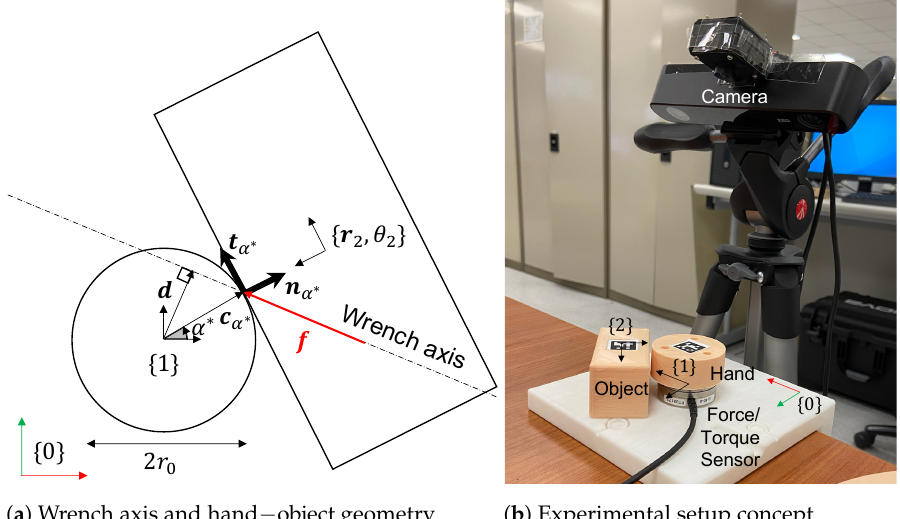
Figure 1. ( a ) Any point on the wrench axis has the same displacement vector d from frame 1. Using Equation (4), we determine c α ∗ , the point of pushing. ( b ) This experimental setup was designed to test the proposed method of estimating the point of contact for circular